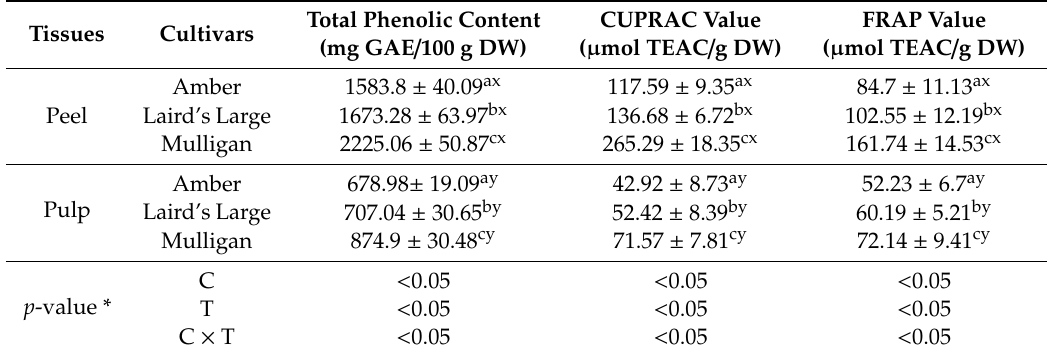
Table 2. Total phenolic content and antioxidant activity of tamarillo separated by cultivars and tissues. Values are expressed as Mean ± SD ( n = 4).